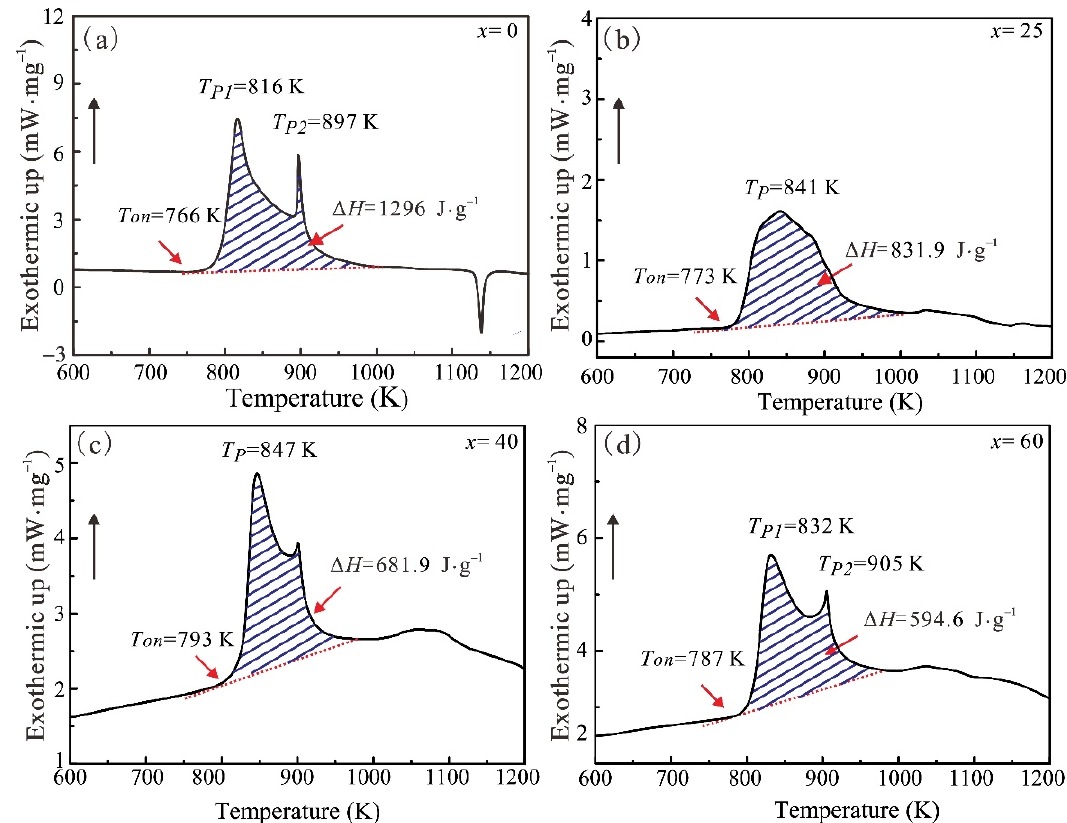
Figure 4. DSC curves of (48Al–52Ni) 100 ‐ x W x composites ( a ) x = 0; ( b ) x = 25; ( c ) x = 40; ( d ) x = 60.